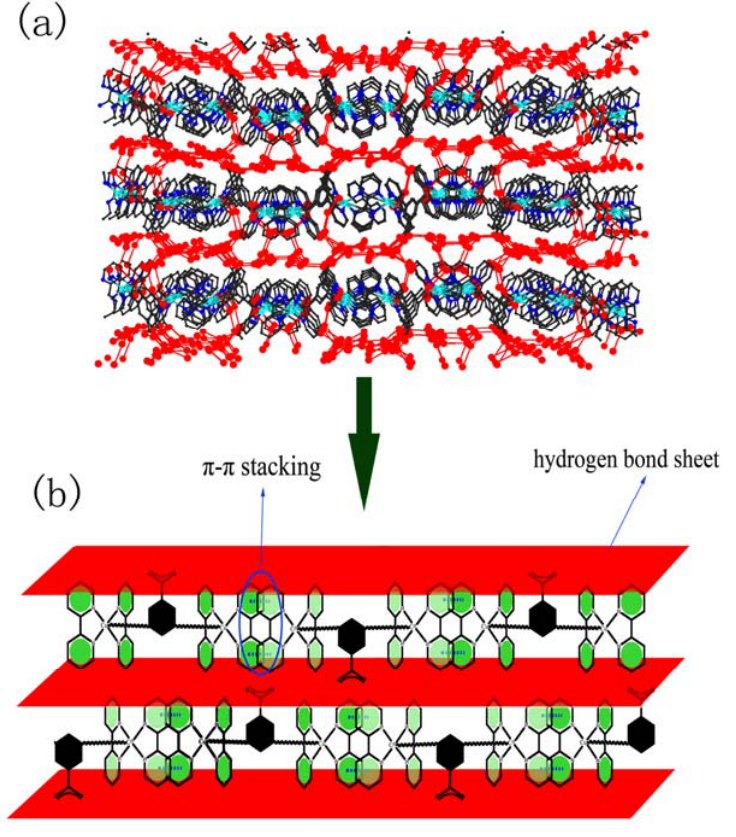
Figure 5. (a) The 2D layers of complex 2 along ac plane. (b) Perspective view of the water layers, showing the π ··· π stacking interactions between the 2,2 ′ -bpy molecules of the